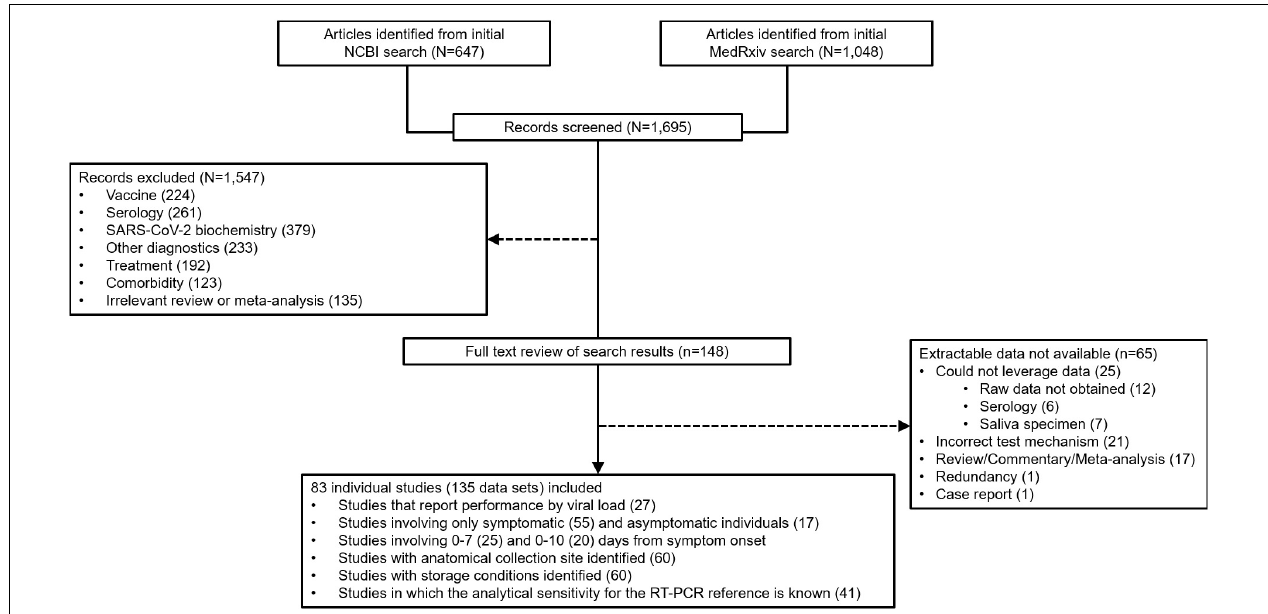
FIGURE 2 | Preferred Reporting Items for Systematic reviews and Meta-Analyses (PRISMA) flow diagram for reconciliation of articles/sources included in this study.